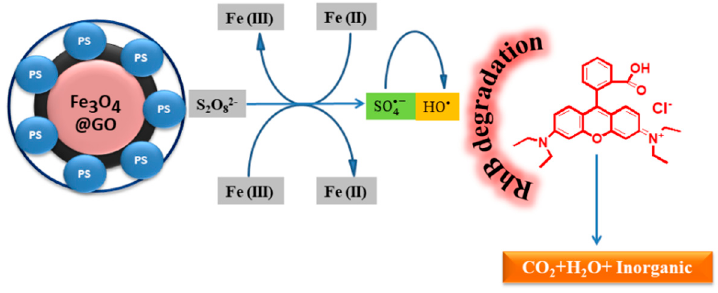
Figure 8. The possible activation mechanism of RhB in the Fe 3 O 4 @GO + K 2 S 2 O 8 system.